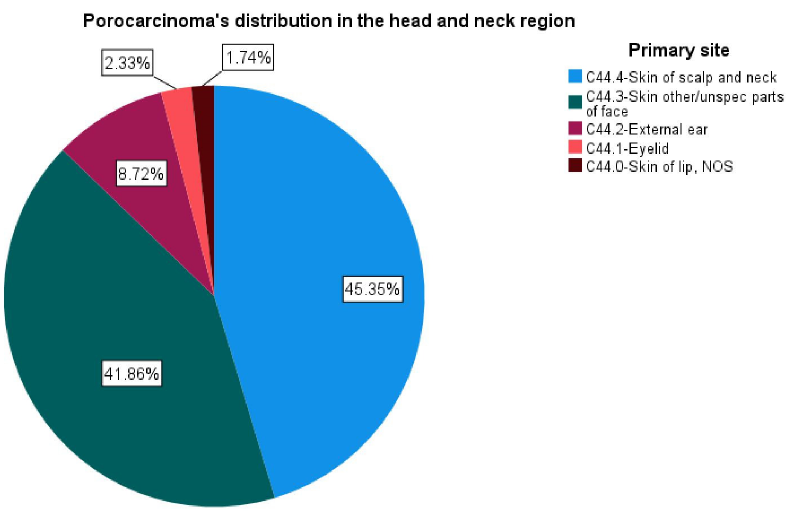
Figure 1. Porocarcinoma distribution in the head and neck region. In the head and neck region, mean age at diagnosis was 66.4 years old ( σ = 17.6), with a range from 10 to 98 years. The median age was 69 years and was similar for the overall population, the head and neck, and other locations. White race was predominant (86%). Males were more affected in the head and neck (64%) compared to other locations (51.2%) ( p < 0.05). size in this region was reported for 72 cases, ranging from 2 to 85 mm, with a mean value of 18.8 mm ( σ = 18.3) and a median value of 13